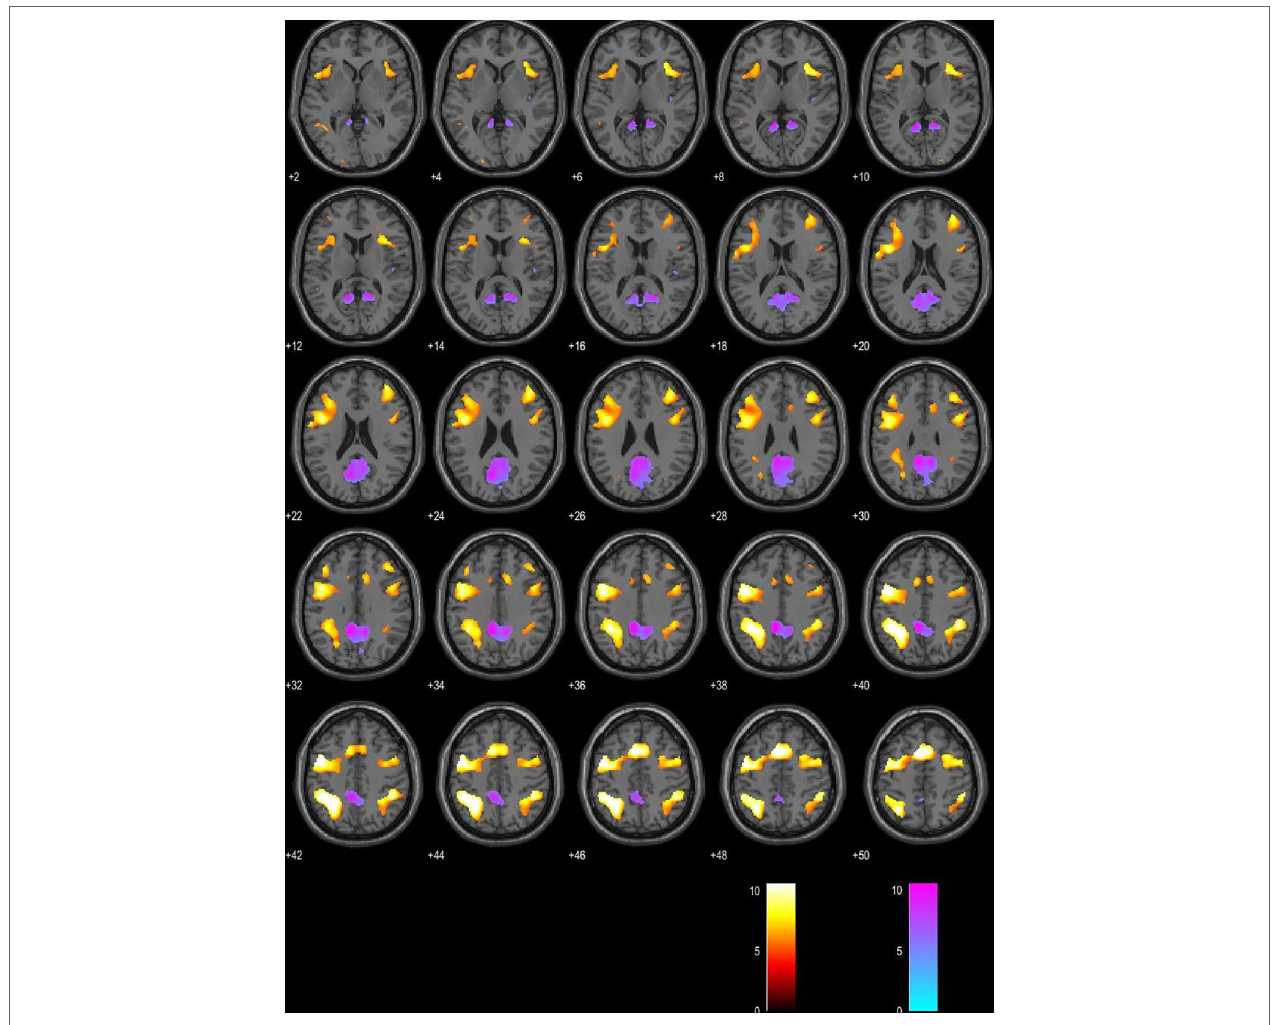
FIGURE 2 | Blood oxygen level–dependent (BOLD) signal associated with higher Modified Fatigue Impact Scale (MFIS) score is presented in the red color map. BOLD signal associated with lower MFIS score is presented in the blue color map. Presented in the axial